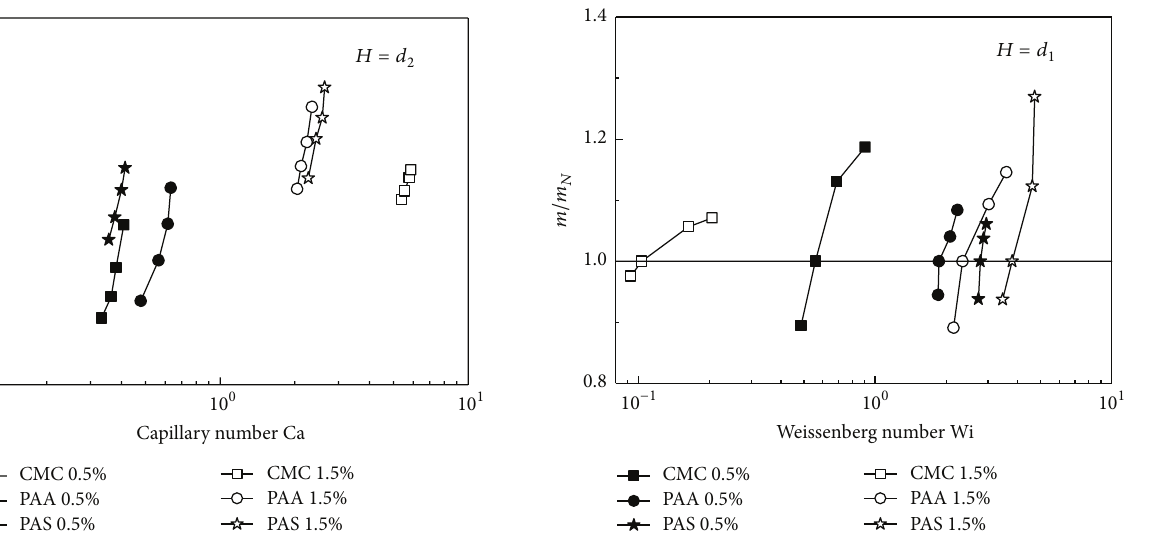
Figure 11: Fractional coverage 𝑚 as a function of capillary number Ca when sudden expansion tube angle is 𝜃 = 45 ∘ , 𝑄 = 600 mL/min and 𝐻 = 𝑑 2 .